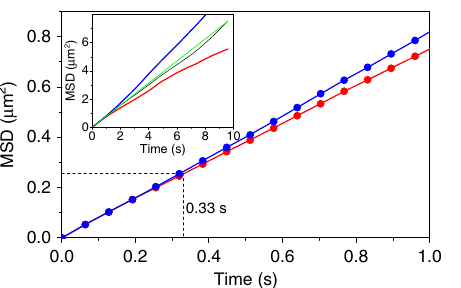
Figure 9 | Effect of the temporal order of the step sizes on MSD- D t profile. MSD-10 D t profiles of the c sh -LO (red) and the d lg -HO (blue) simulated trajectories. The inset shows the full MSD-10 D t profiles of these simulated trajectories. The black and green lines show the MSD profile of the original experimental replicate and its theoretical 10 D t profile.